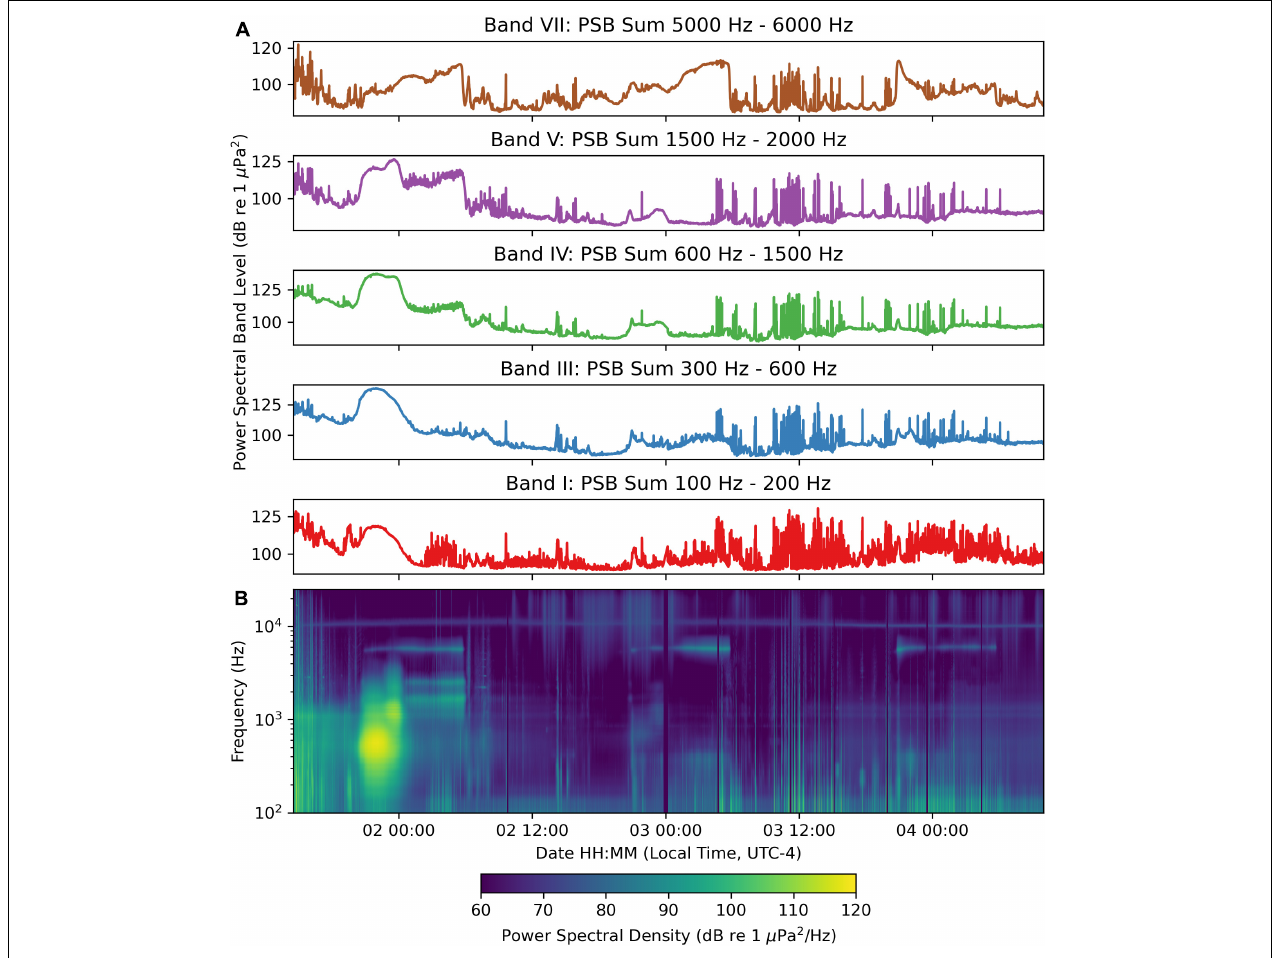
FIGURE 3 | Sound recorded continuously by the wave glider Blackbeard between August-01 and August-04. (A) Power spectral band sums for 60 s windows of the recording. (B) Composite spectrogram produced from 60 s average power spectral